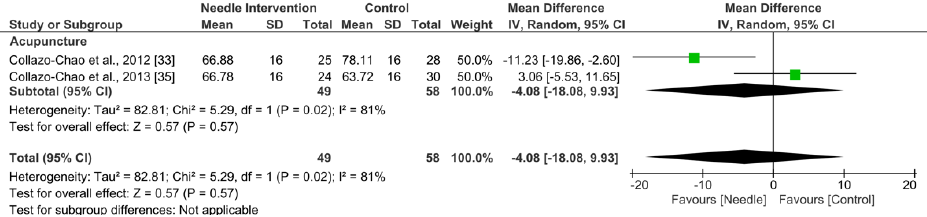
Figure 5. Forest plot for FIQ after 0 – 3 months.